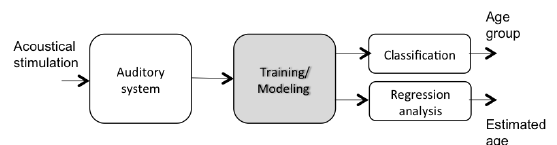
Figure 1. Flowchart of the proposed auditory perception based age classification and estimation